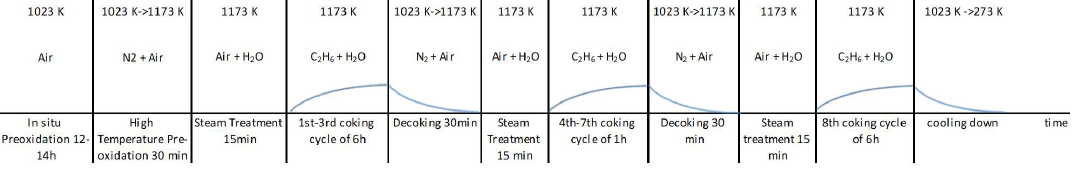
Figure 3. Timeline of a cyclic aging experiments. Table 1. Schematic overview of the coking-decoking experimental procedure.